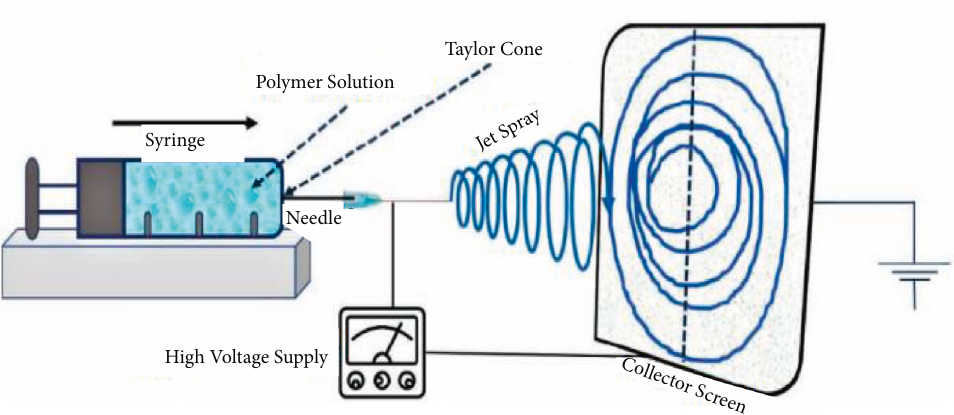
Figure 3: A schematic illustration of the electrospinning technique (there are principally 3 components to complete a functional elec- trospinning setup: high voltage power supply, spinneret constituted by the needle of small diameter, and a grounded metal collecting